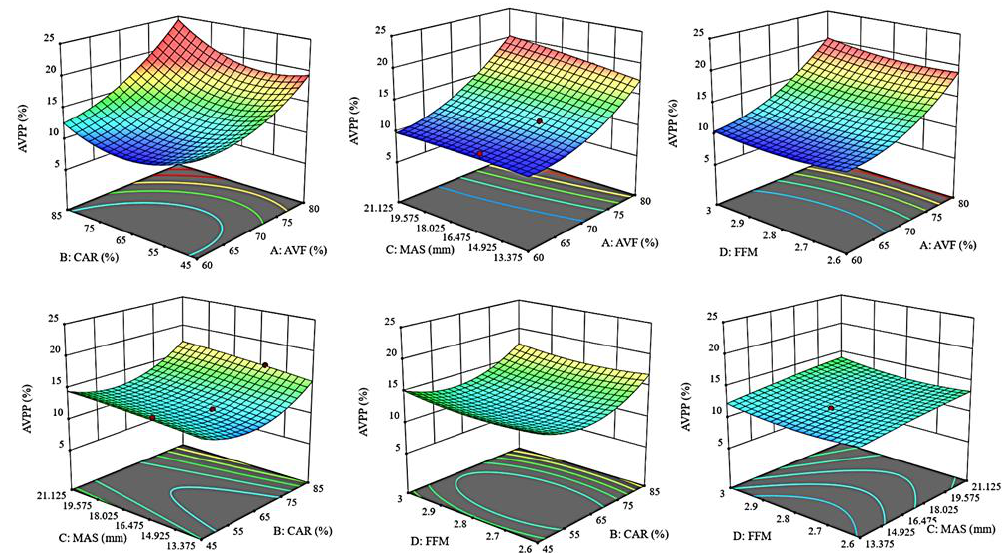
Figure A2. Response surface of the AVPP model.